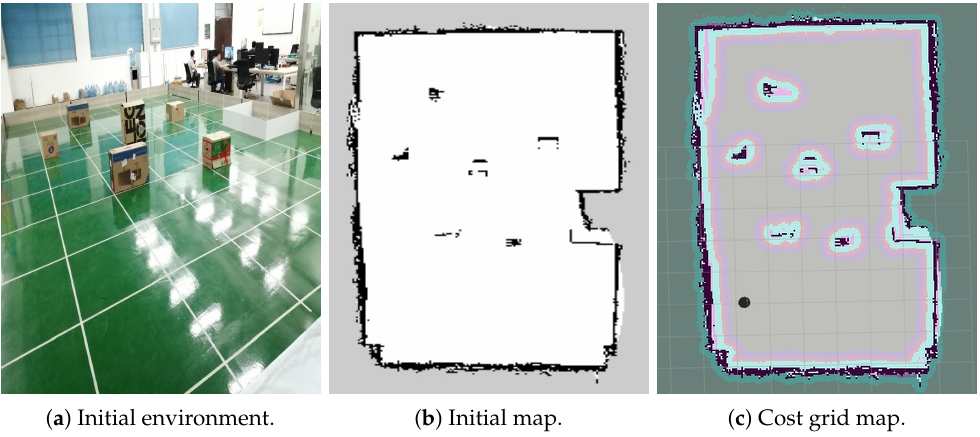
Figure 15. Initial environment and its cost grid map before/after